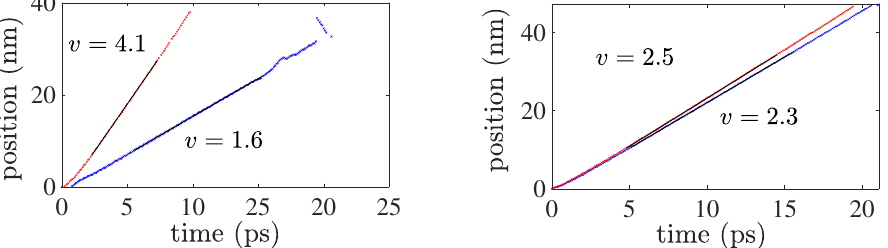
Figure 8. Position as a function of time for edge ( left ) and screw ( right ) partial dislocations in the bulk (blue crosses) and on the twin boundary (red crosses) subject to a load of T xy = 1 GPa in the edge, and of T zy = 1 GPa in the screw, case. Position here denotes x from Figure 2 in the direction of dislocation line motion m = i x . Note that the applied stress induces a Peach-Köhler glide force f gl of approximately 0.15 N/m along on all dislocations.